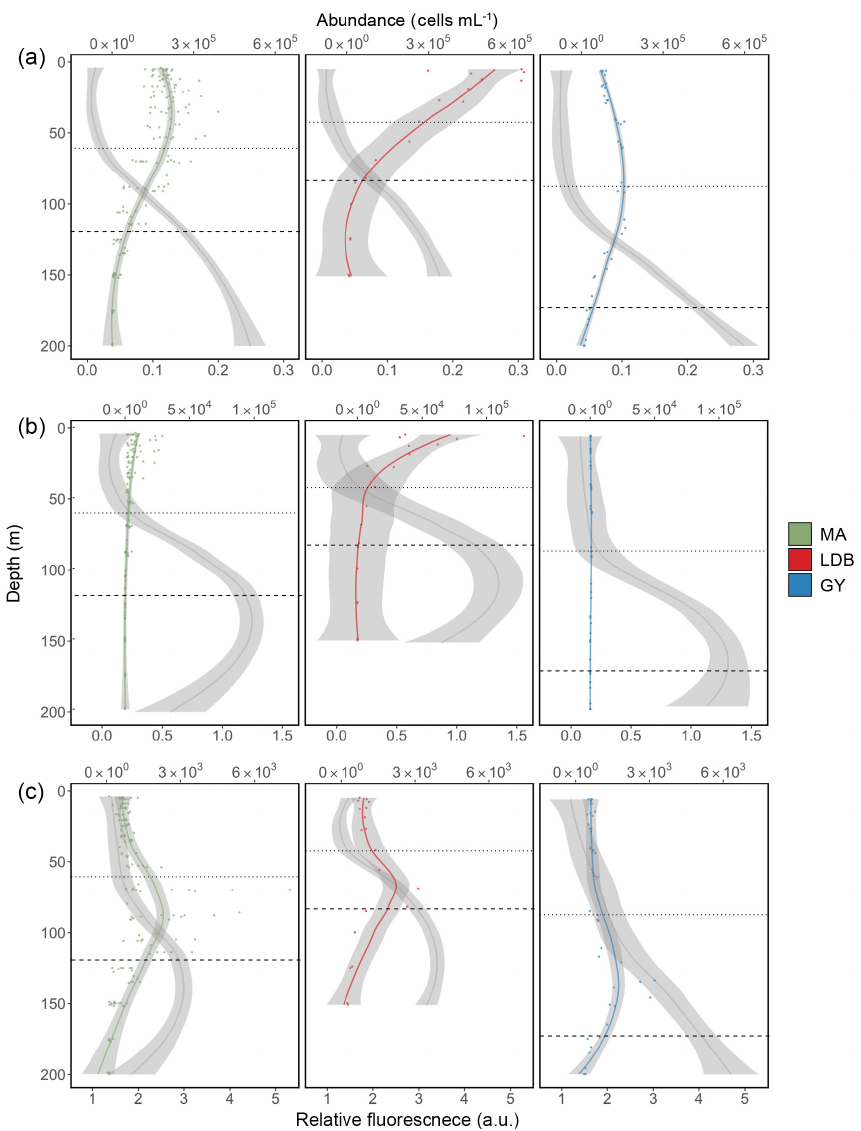
Figure 3. Abundance profiles for Prochlorococcus (a) , Synechococcus (b) , and PPE (c) . Color-coded lines represent average cell abundance; grey lines represent the relative fluorescence for each group, based on cytometry data. Color-coded points represent original observations for biogeochemical region (MA, LDB, and GY) with shading representing standard error. Dotted and dashed horizontal lines represent average PAR 2 . 7 and PAR 0 . 1 depths,